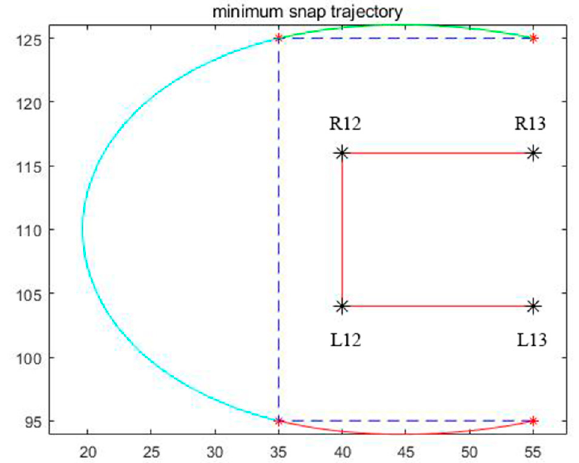
Figure 4. Deviation between trajectory and straight-line path.